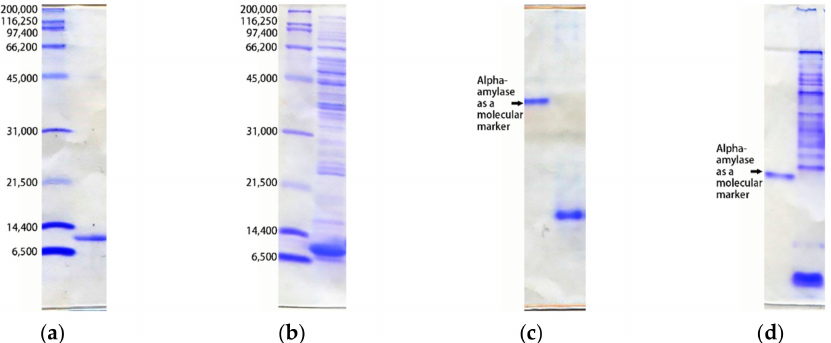
Figure 3. SDS-PAGE (( a ) and ( b )) and Native-PAGE (( c ) and ( d )) analysis of typical protein samples. In all gels, the left lanes are for molecular markers. ( a ) The homogenous sample of an artificial peptide with 130 amino acid residues (pI = 5.1)) migrates as a single band in SDS-PAGE; ( b ) the sample containing contaminated protein gives many bands other than the target protein in SDS-PAGE; ( c ) the electrically homogeneous sample migrates with speed proportional to its charge as a single band in Native-PAGE (left lane: a highly-purified alpha-amylase as a marker protein); ( d ) the sample with electrically heterogeneous contaminants migrates as a smear and ladder in Native-PAGE (left lane: highly-purified alpha-amylase as a marker protein). In SDS-PAGE, the band in the gel migrates to the position corresponding to the molecular weight of the protein. SDS binds to amino acids of the protein molecule, denatures and coats the protein, and produces negative charges. Then, the protein molecules with SDS migrate in the gel by imposing an electric field. Beta-mercaptoethanol is also applied to reduce disulfide bonds. In Native-PAGE, the band in the gel migrates to the position corresponding to the polarity and amount of electric charge, which is also a ff ected by the molecular size and shape.